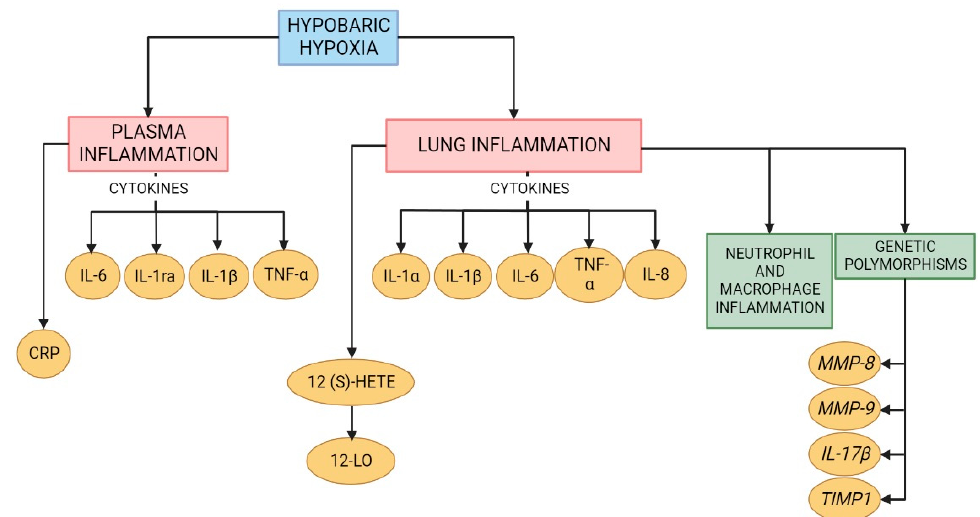
Figure 2. Schematic representation of the molecules involved in lung and plasma inflammation under hypobaric hypoxic conditions. Created with BioRender.com.